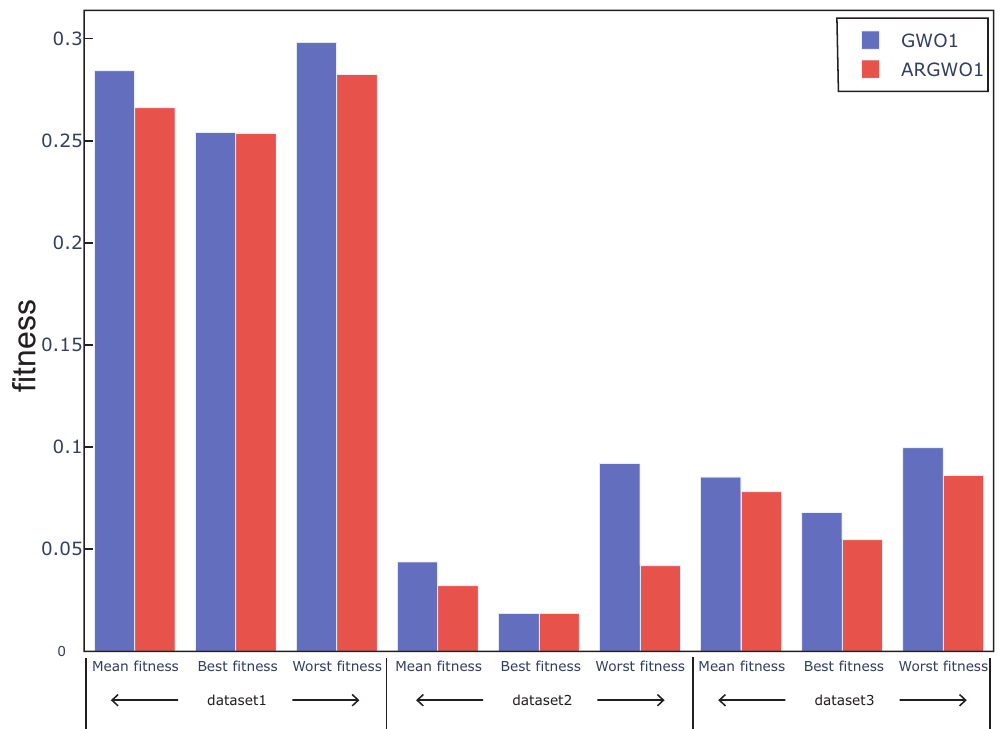
Figure 5. Mean, best, and worst fitness obtained from different algorithms over dataset3.